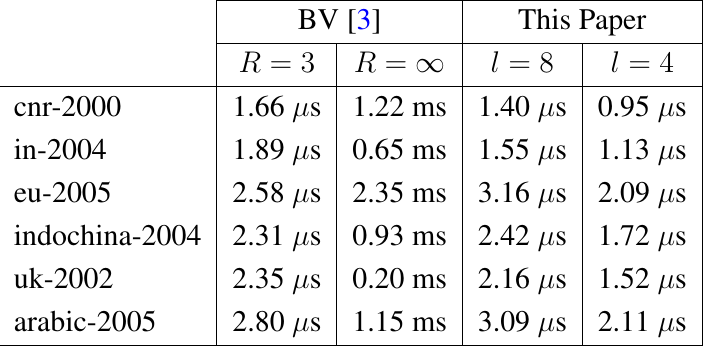
Figure 4. Algorithm to check if the directed link ( v